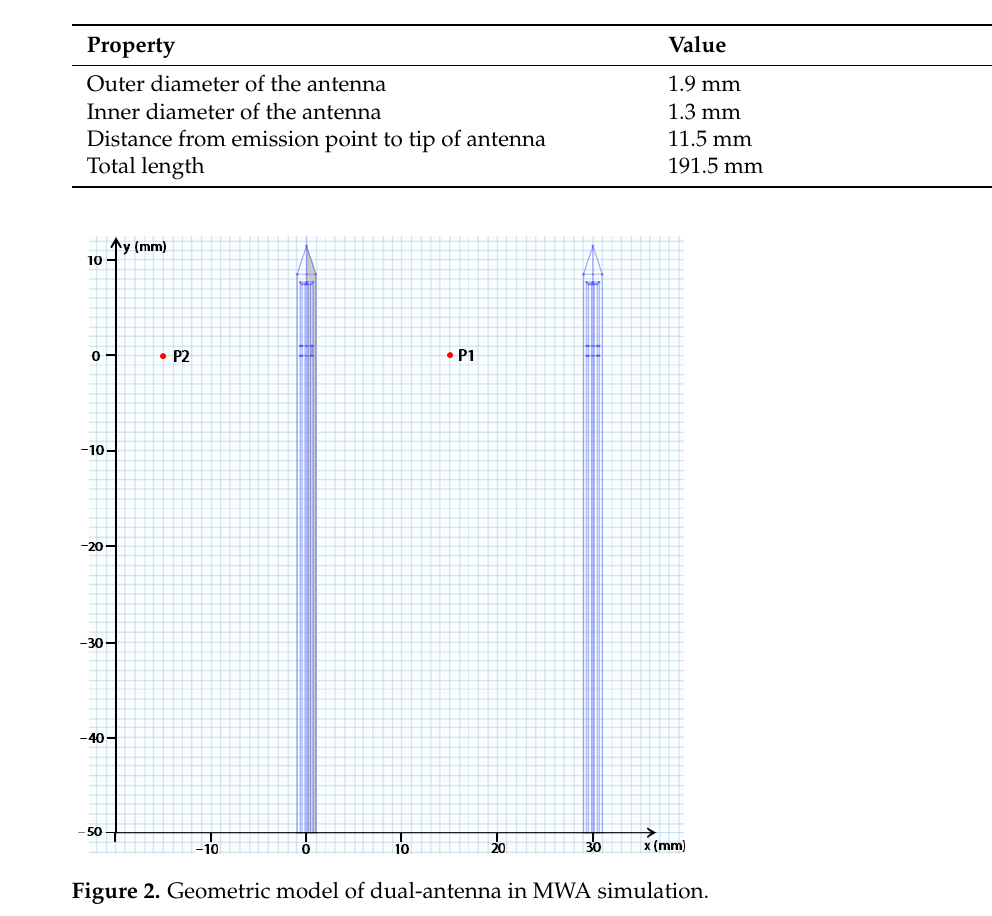
Figure 2. Geometric model of dual-antenna in MWA simulation.